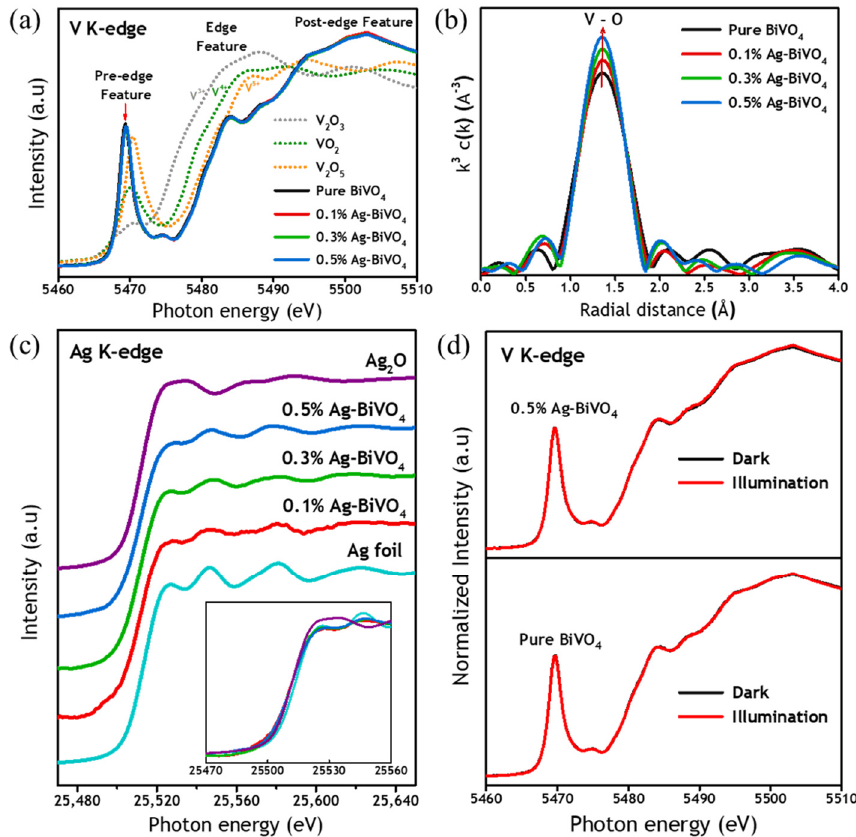
Figure 3. ( a ) XAS spectra at V K-edge. The pre-edge feature is assigned to 1s → 3d transition (allowed by 3d–4p orbital hybridization). Above the absorption edge, the first strong peak is assigned to a dipole-allowed transition 1s → 4p. ( b ) Fourier-transformed EXAFS of V K-edge in R-space. ( c ) XANES spectra at Ag K-edge. ( d ) In situ XAS at V K-edge in the dark and under illumination. To confirm the oxidation state of Ag in our samples, the Ag K-edge is measured for all films that contain Ag NPs, as shown in Figure 3c. The absorption edges of these sam- ples hardly vary. The Ag signals are closed to the characteristic spectrum of Ag foil, indi-